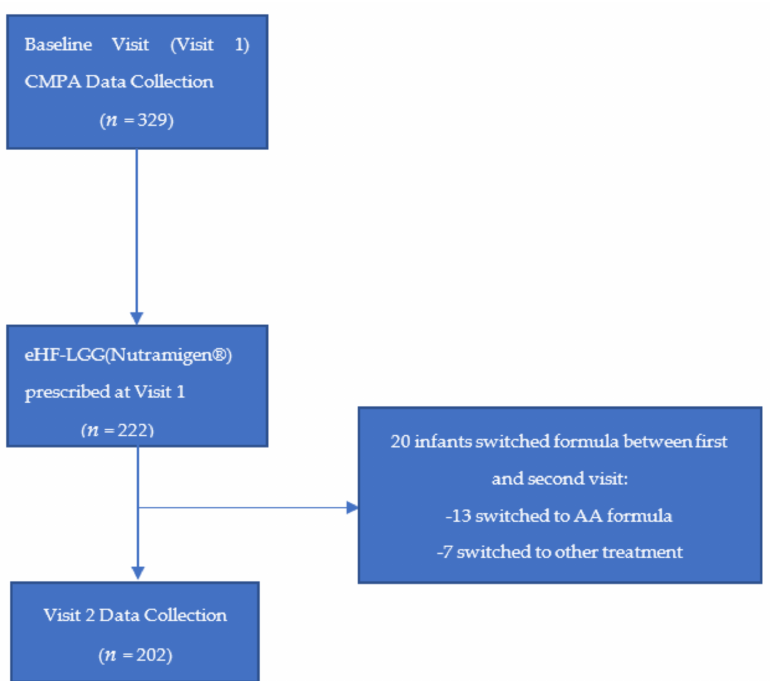
Figure 1. Flow Diagram of initial population vs. final population included in data analysis after application of the inclusion and exclusion study